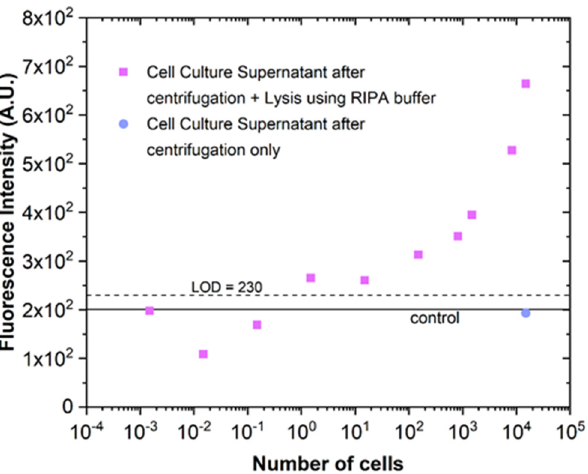
Figure 6. Cell lysis monitored through AK detection in a microfluidic chip. AK detection immunoassay was performed in solutions obtained by sequentially diluting a stock lysate solution with a concentration of 1.6 × 10 6 cells/mL (pink squares) and in a solution of cells subjected only to centrifugation (blue) (n = 1). The control results from non-specific interactions and the residual capture of free detection antibodies when only the complete cell culture growth medium flowed through